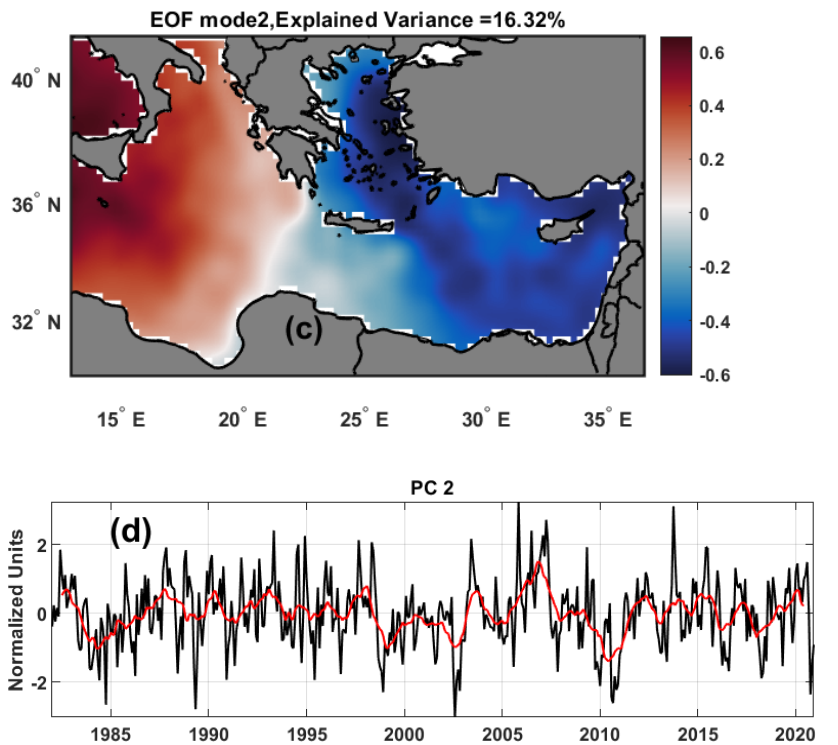
Figure 5. ( a ) Spatial distribution for the principal (EOF) component (PC1). ( b ) Temporal evolution for EOF (PC1) in normalised variance units. ( c ) Spatial distribution for the second (EOF) component (PC2). ( d ) Temporal evolution for EOF (PC2) in normalised variance units; for the EMED SST anomaly covering the period from 1982 to 2020. In ( b , d ), the deseasoned monthly PCs time series is shown in continuous black lines, and the low passed using a 13-month running mean is shown in continuous red lines.